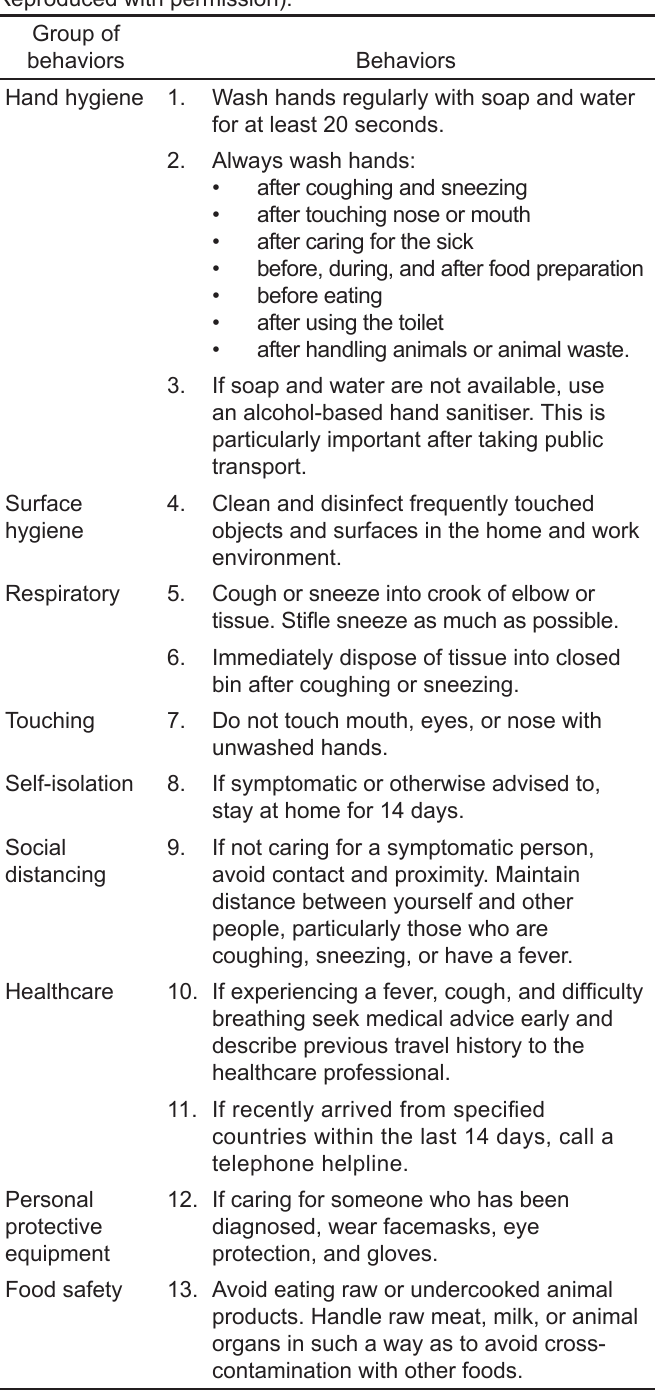
Table 2. Thirteen behaviours to reduce transmission 6 (© 2020 Susan Michie & BMJ Publishing Group Ltd. All rights reserved. Reproduced with